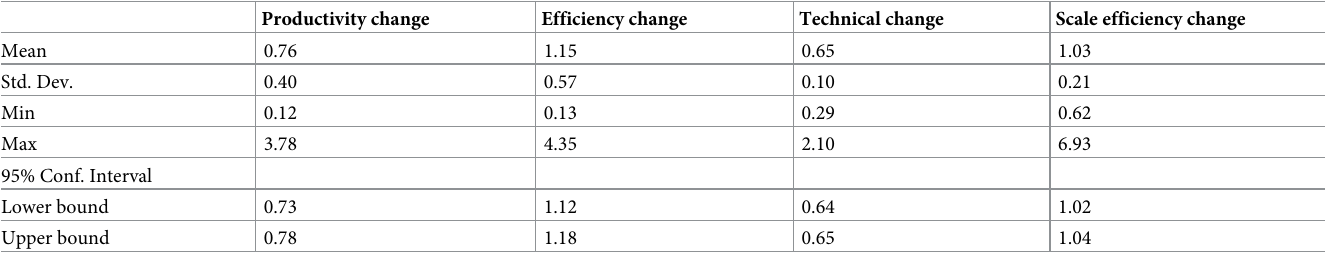
Table 5. Average Malmquist productivity index and its components of the sample households for the period 2011 and